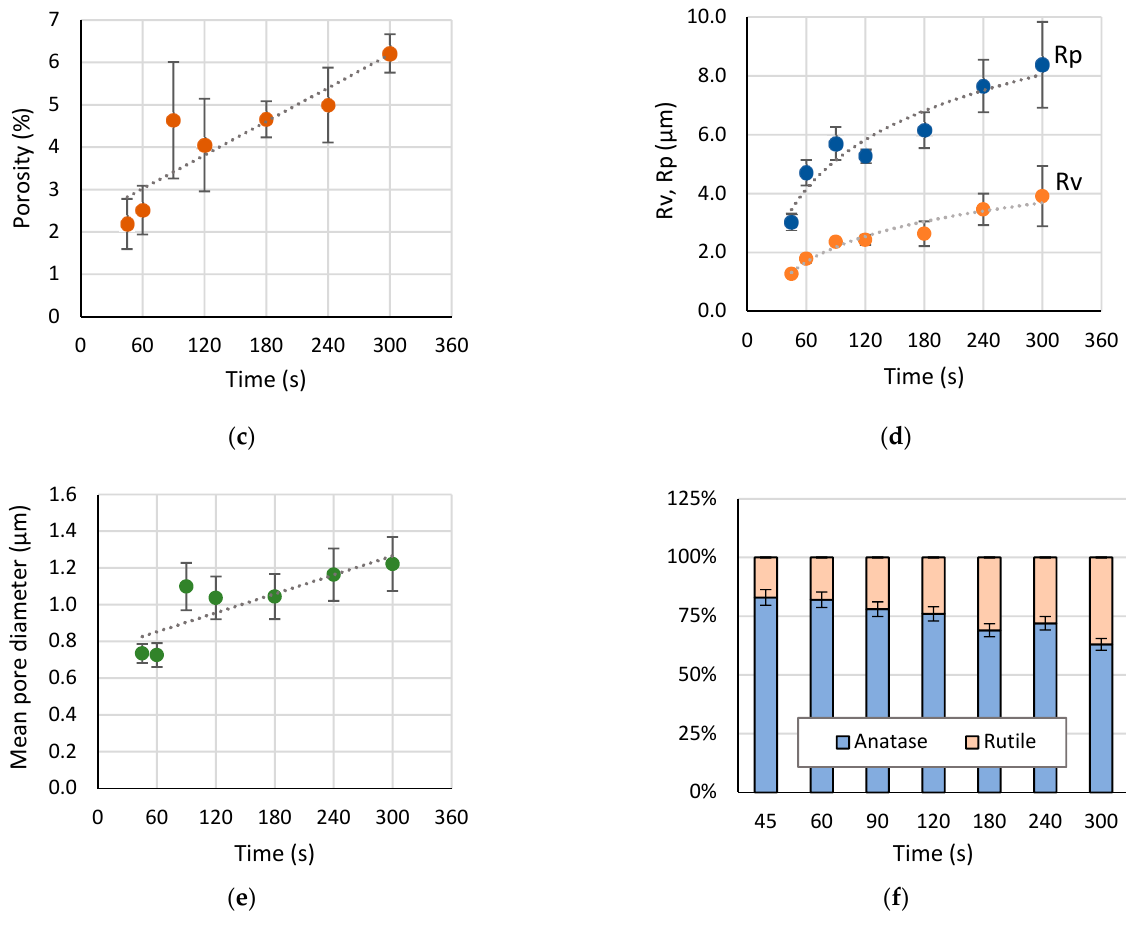
Figure 5. Coating properties vs. PEO treatment times: ( a ) coating thickness; ( b ) surface roughness Ra; ( c ) porosity; ( d ) peak height Rp and valley depth Rv; ( e ) mean pore diameter obtained from the lognormal distribution; ( f ) anatase and rutile content in the coating.